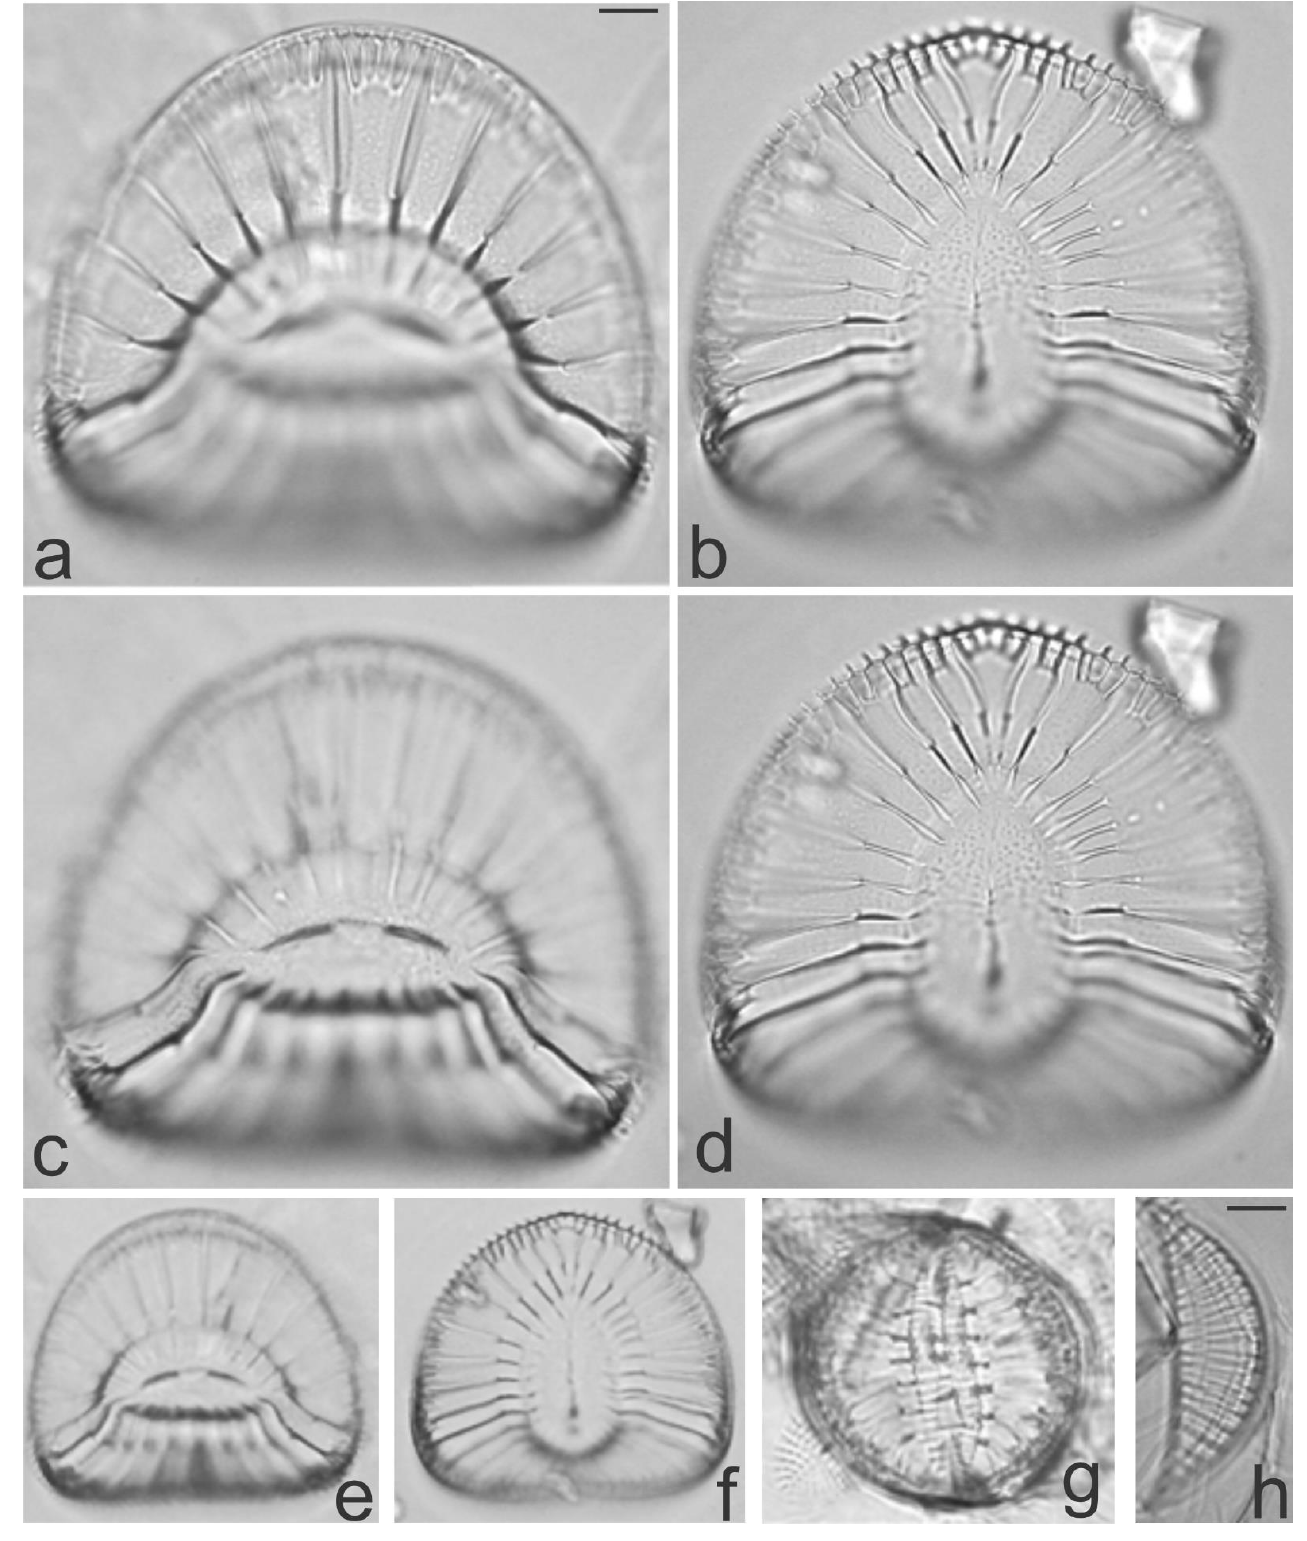
Figure 35. ( a – d , e , f ) Coronia ambigua ; ( g ) Campylodiscus simulans ; ( h ) Epithemia pacifica . Scale bars: ( e , f ) = 10 μm; all others = 5 μm.